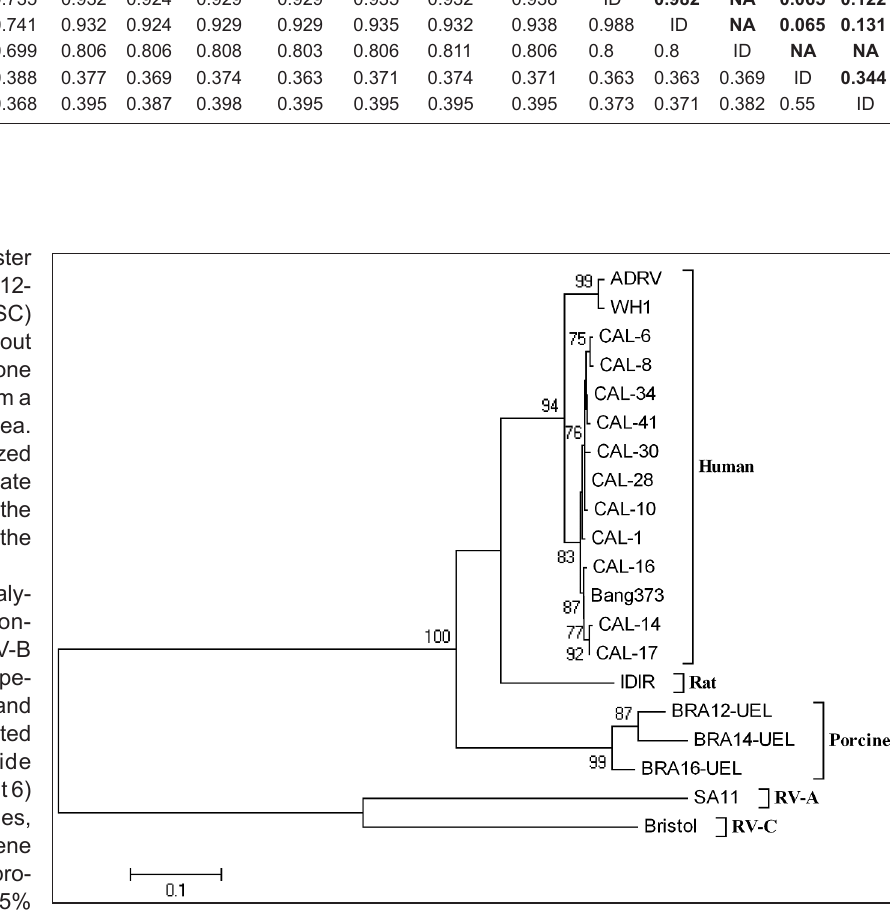
Figure 1. Phylogenetic tree between group B rotavirus human strains [CAL-1 (AY238383), CAL-6 (AY941792), CAL-8 (AY864913), CAL-10 (AY864914), CAL-14 (AY941778), CAL-16 (AY941789), CAL-17 (AY941776), CAL-28 (AY941777), CAL-30 (AY941790), CAL-34 (AY941791), CAL-41 (AY941779), Bang373 (AY238393), ADRV (AJ867609), and WH1 (AY212934)]; rat strain [IDIR (U03558)], and porcine strains [BRA12-UEL (EF577257), BRA14-UEL (EF577258), and BRA16- UEL (EF577259)] based on part (356 nucleotides) of the NSP2 gene. The SA11 (DQ838615) primate group A rotavirus (RV-A) strain, and Bristol (AJ132205) human group C rotavirus (RV-C) strain were used as an outgroup. The tree was constructed as described in Material and Meth- ods.